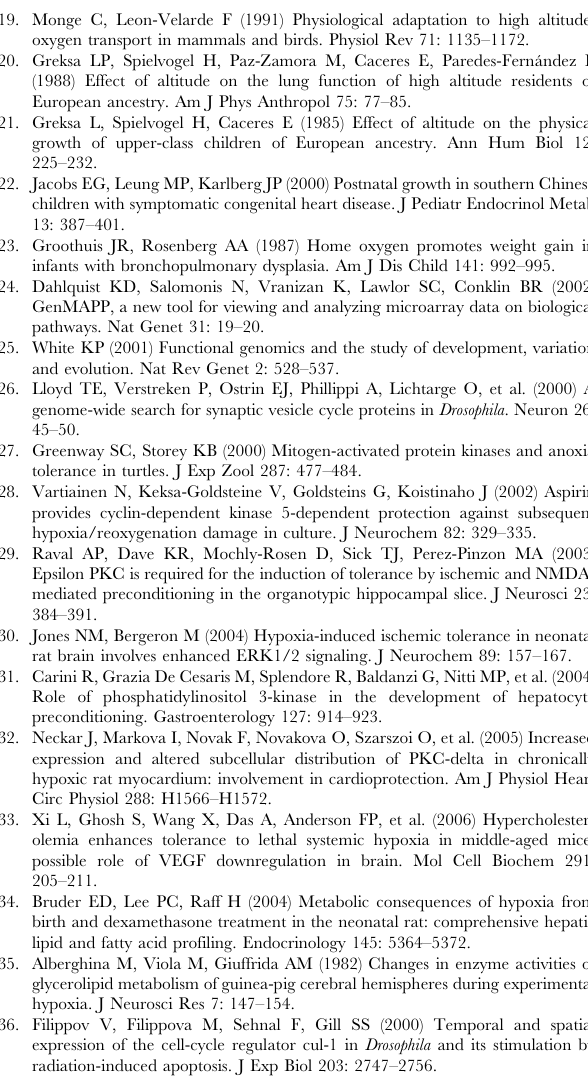
Figure S2 The recovery time of individual parental lines from anoxic stupor. Recovery time from anoxic stupor of each individual parental line was measured using 5 to 6 days old male adult flies, the recovery time ranged from 319 to 515 seconds demonstrating a significant genetic variation among these lines (ANOVA, p , 0.0001). Found at: doi:10.1371/journal.pone.0000490.s005 (1.84 MB